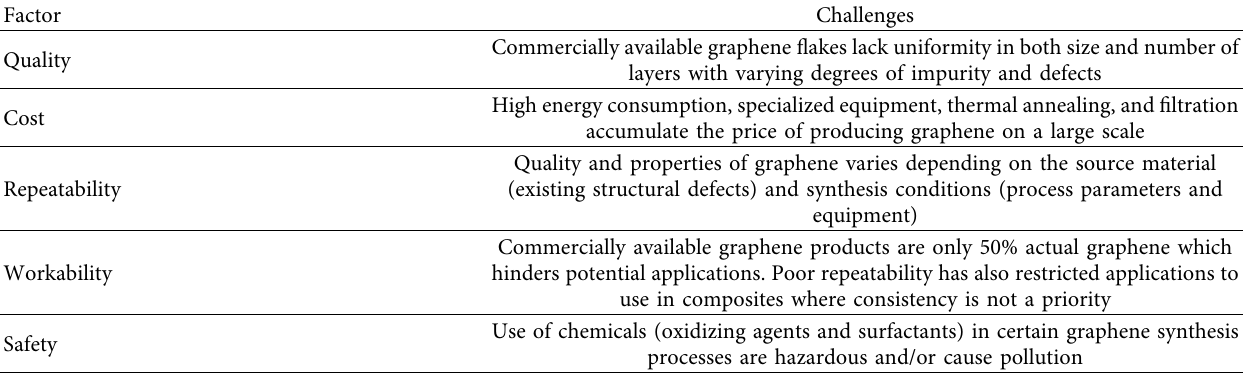
Table 2: Challenges in industrial-scale graphene synthesis